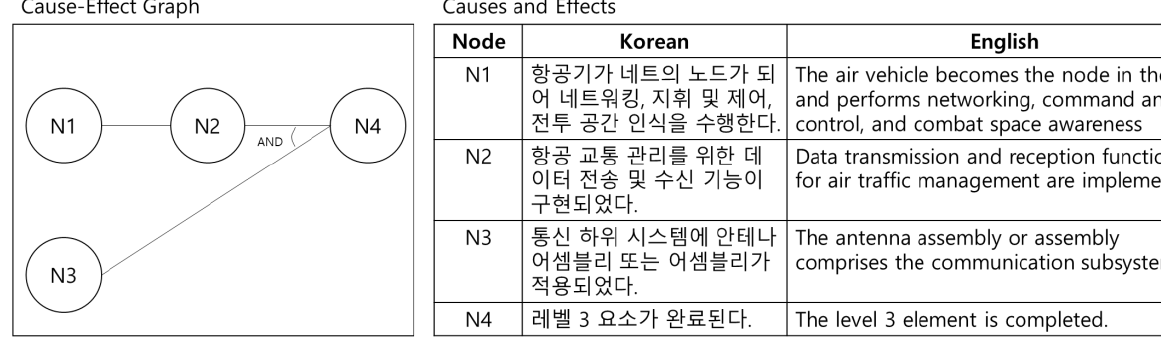
Figure 13. Cause-Effect Graph generated from C3Tree Model.